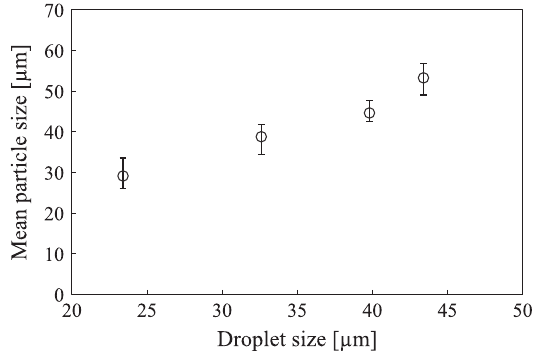
Fig. 2 Change in mean particle size of alanine against droplet size during the instillation process with an inkjet nozzle. Reprinted with permission from Ref. (Tamura et al., 2014). Copyright: (2014) Elsevier.